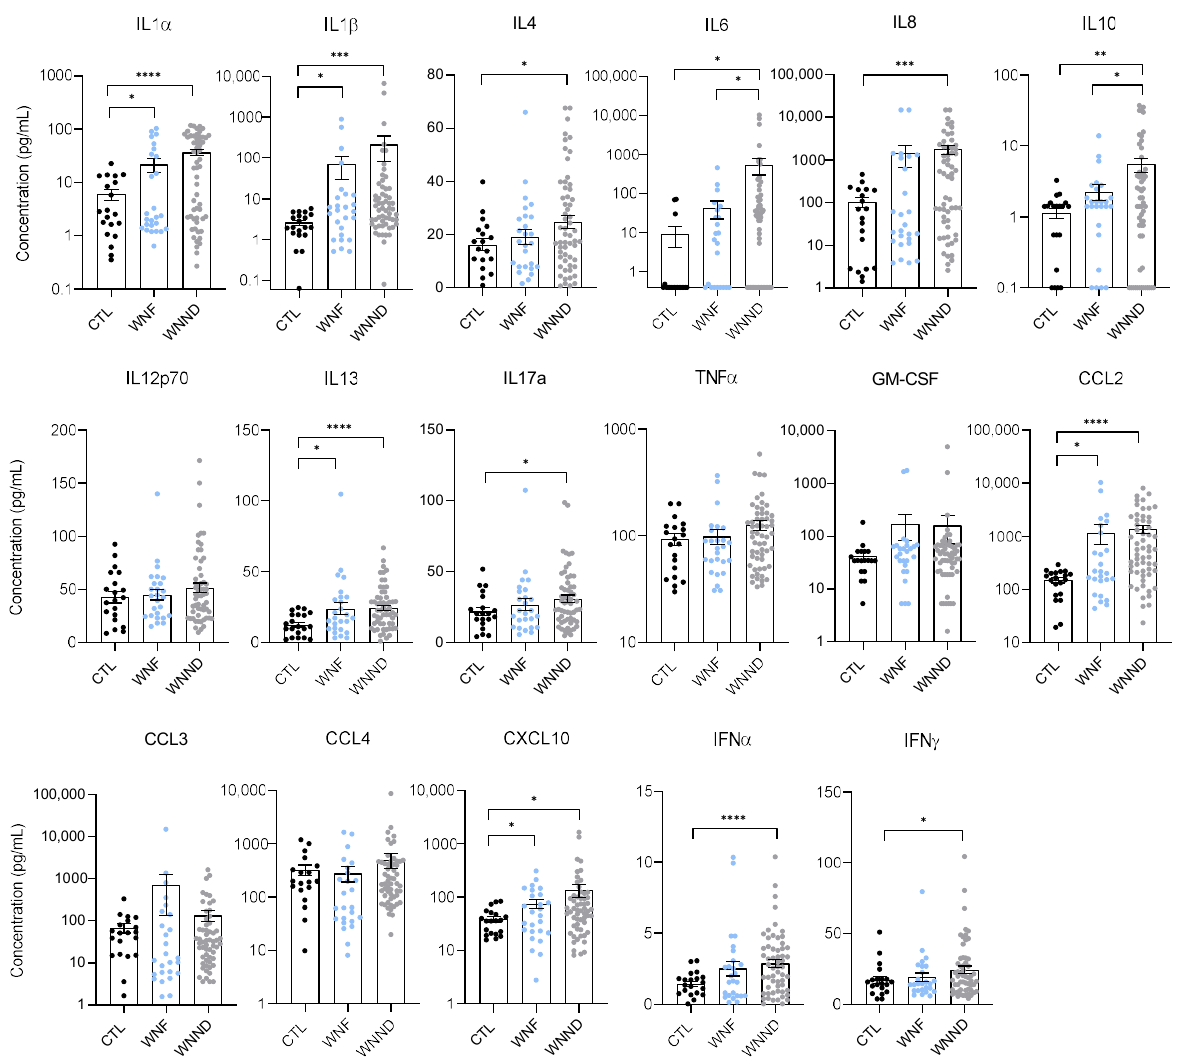
Figure 2. WNV infection results in systemic inflammation in patient sera. Plasma concentration in pg/mL of different pro-inflammatory markers of non-infected CTL (black), WNF (blue) and WNND (grey) humans, measured by multiplex bead-based ELISA. Bars show means ± SEM (* p < 0.05, ** p < 0.01, *** p < 0.001, **** p < 0.0001).